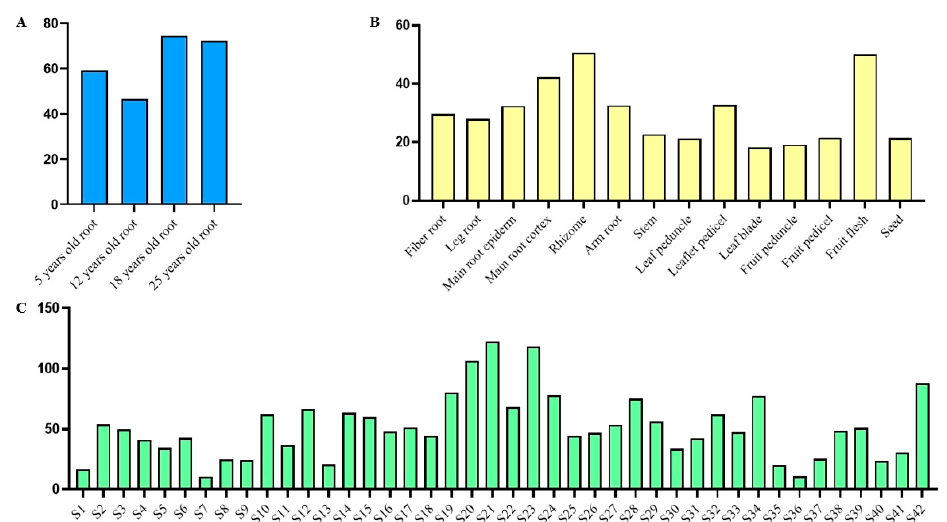
Figure 5. Expression of PgGRAS68-01 gene in ginseng. ( A ) Expression of PgGRAS68-01 gene in the 4 different aged stages of ginseng roots. ( B ) Expression of PgGRAS68-01 gene in 14 different tissues of 4-year-old ginseng. ( C ) Expression of PgGRAS68-01 gene in the 42 farmer’s cultivars of 4-year-old ginseng roots.